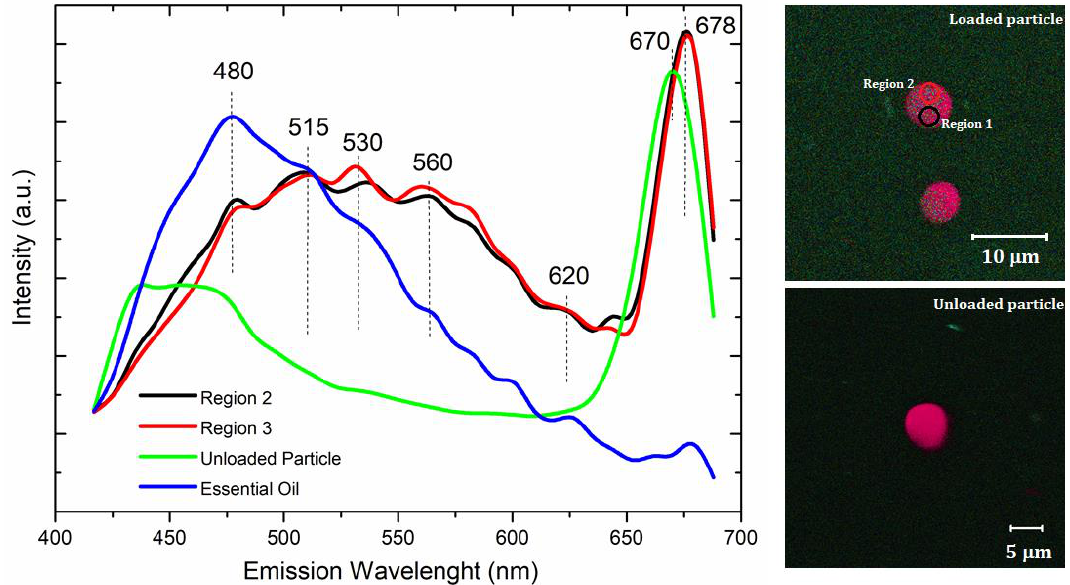
Figure 7. Fluorescence measurements of the loaded (regions 1 and 2) and unloaded particles.